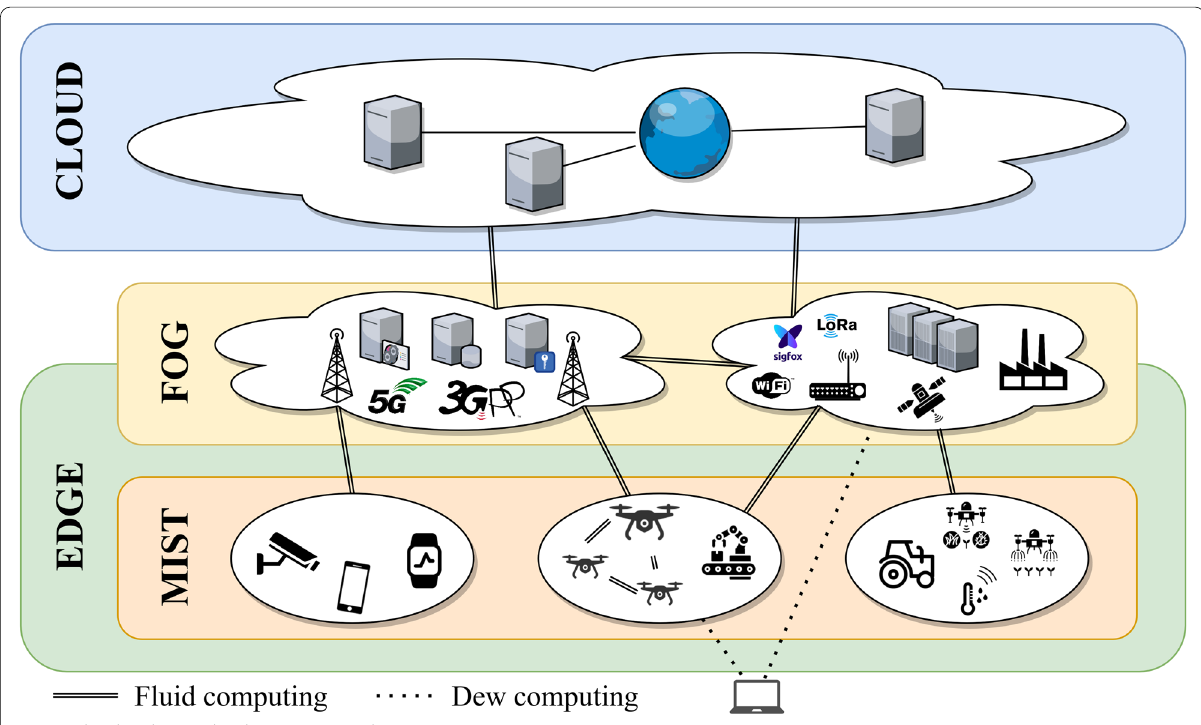
Fig. 2 Cloud and post‑Cloud computing